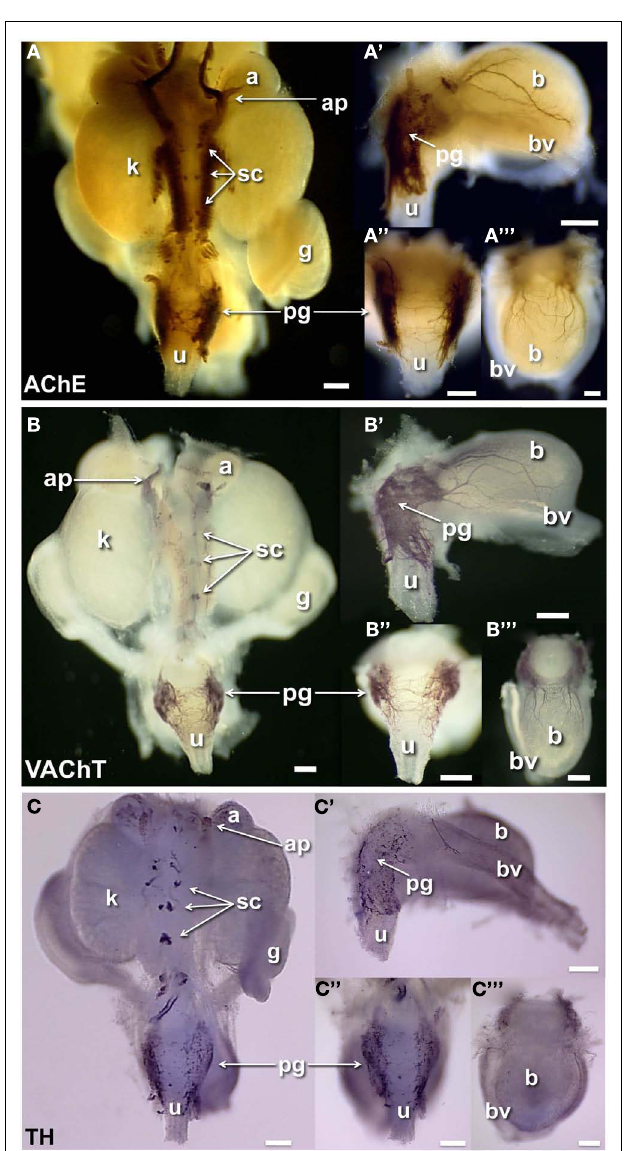
FIGURE 2 | Distribution of cholinergic and noradrenergic elements in fetal mouse LUT. Whole-mount images of male 15.5dpc fetal UGT samples stained by AChE histochemistry localizes primarily cholinergic innervation and some other neuronal subtypes (A) . IHC staining of female 15.5dpc fetal LUT detects specifically cholinergicVAChT + neurons (B) . IHC staining of female LUT detects sympathetic noradrenergic innervation labeled by tyrosine hydroxylase immunoreactivity (C) . (A–C) Consist of whole-mount images of 15.5dpc urogenital tissues including dorsal views (A–C) , lateral views of bladder (A (cid:48) –C (cid:48) ) , dorsal views of urethra (A (cid:48)(cid:48) –C (cid:48)(cid:48) ) , and anterior view of bladder (A (cid:48)(cid:48)(cid:48) –C (cid:48)(cid:48)(cid:48) ) . (a, adrenal; ap, adrenal plexus; b, bladder; bv, blood vessel; g, gonad; k, kidney; pg, pelvic ganglia; sc, sympathetic chain; u, urethra; scale bar = 300 µ m). At 15.5dpc pelvic ganglia were strongly VAChT + and numerous VAChT + fibers were present in the dorsal aspect of the